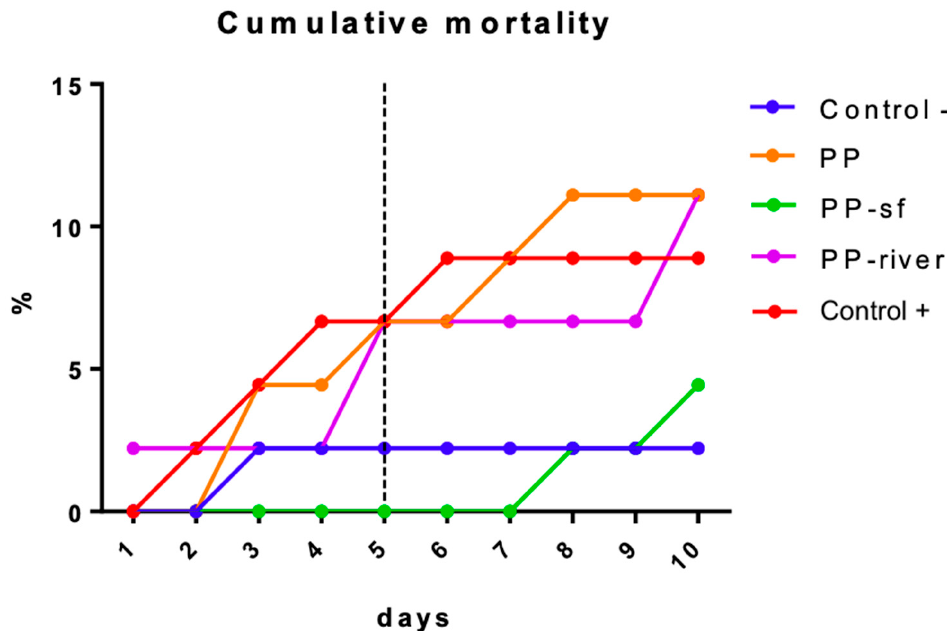
Figure 5. Cumulative mortality (in percentage; average values of three replicates) of Hydropsyche pellucidula during exposure in the four treatment groups (Control − , PP, PP-sf, PP-river, Control+). The dashed line indicates the midpoint of the experiment. Control − denotes negative control; PP polypropylene unconditioned; PP-sf denotes polypropylene preconditioned in Triton X-100 solution; PP-river polypropylene preconditioned in riverine water; Control+ positive control.